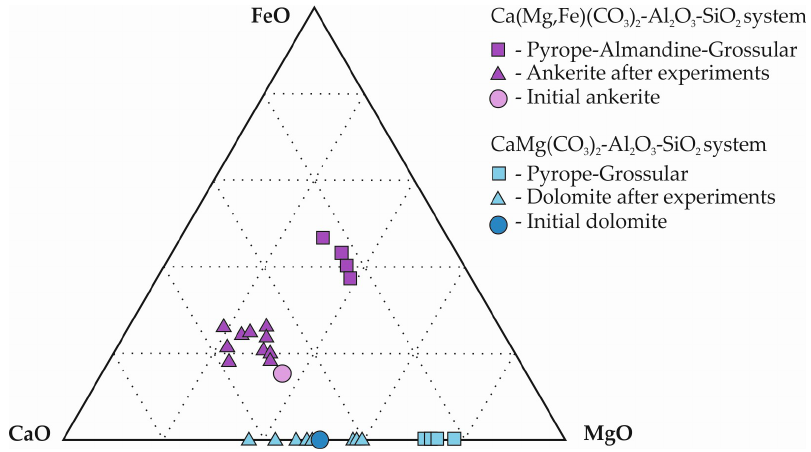
Figure 11. Triangle diagram of the averaged chemical compositions (mol.%) of garnets and carbonates.